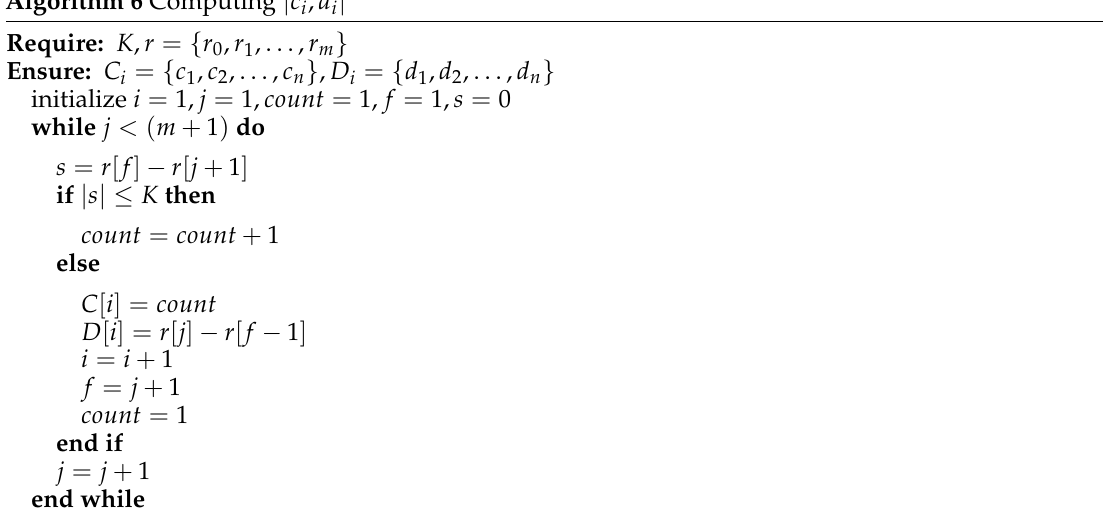
Algorithm 6 Computing | c i , d i